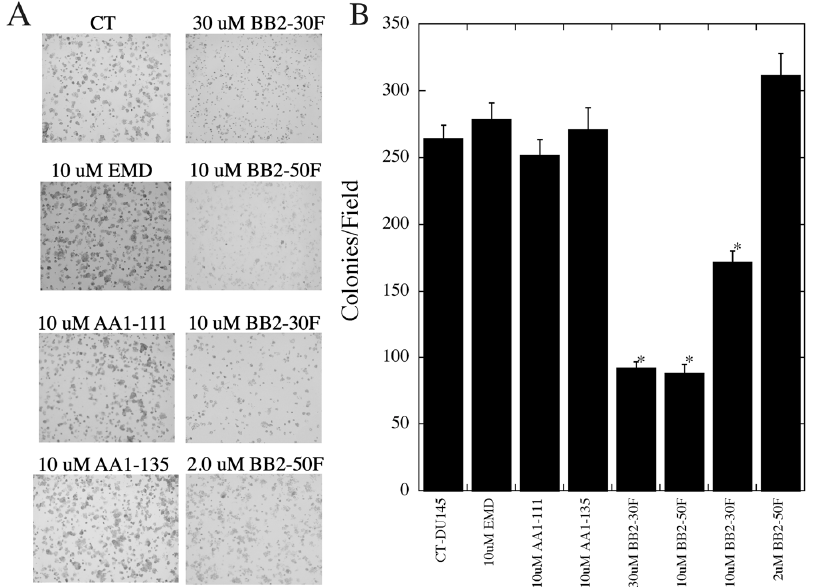
Figure 6. Effects of pharmacological compounds on anchorage-dependent colony formation of DU 145 cells. ( A ) Examples of results. ( B ) Summary of mean +/ − SE of 4 experiments. Colony formation was measured as described in the Section 4; * indicates significant differences from untreated control cells at p < 0.05.